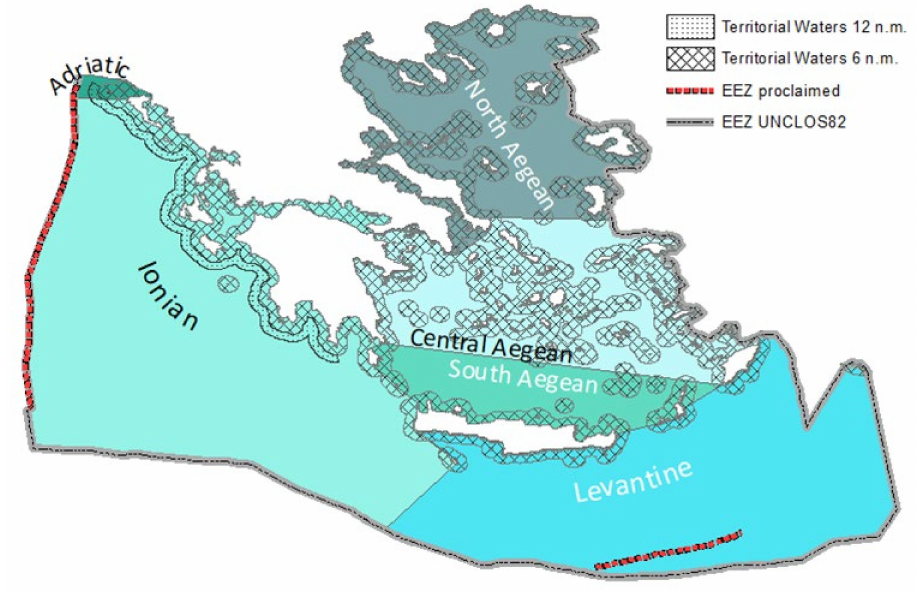
Figure 1. The territorial waters of Greece and marine reporting units as in